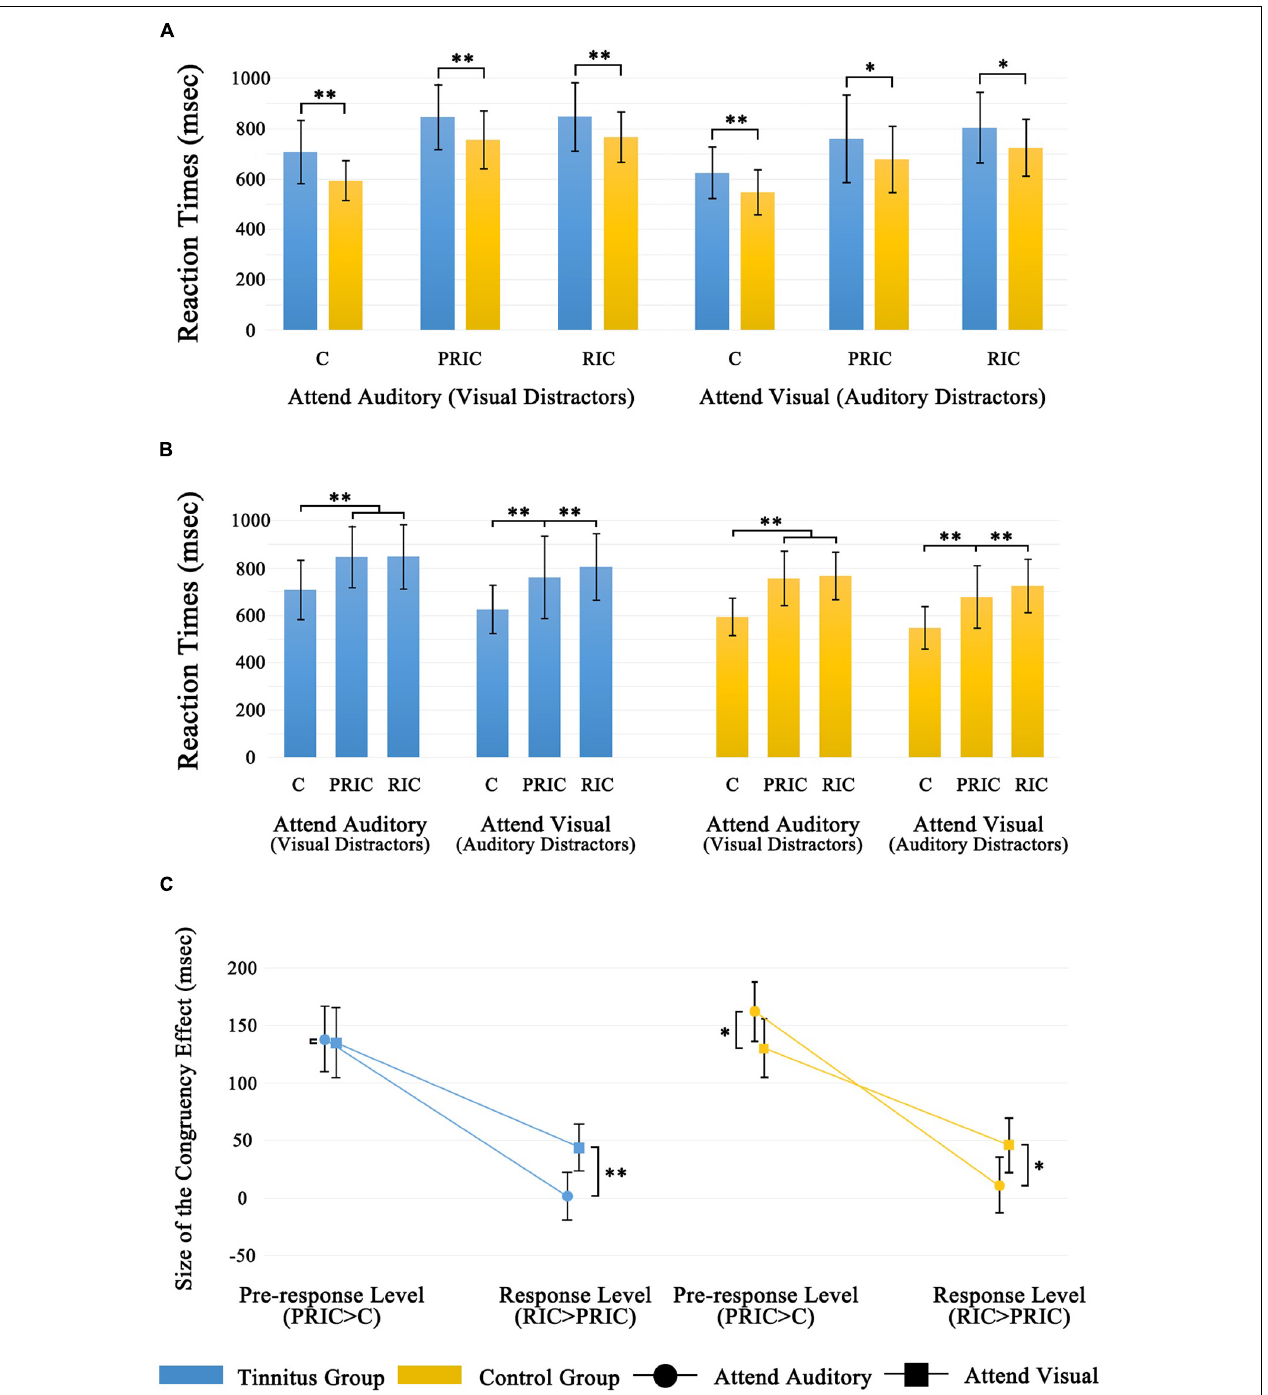
FIGURE 2 | Behavioral results of Experiment. (A) Inter-group differences of the six experimental conditions. (B) Intra-group differences of the six experimental conditions. (C) Inter-group differences of sizes of cross-modal conflict at the preresponse (PRIC > C) and response (RIC > PRIC) levels are shown as a function of the attended modality. ∗ p < 0.05; ∗∗ p <